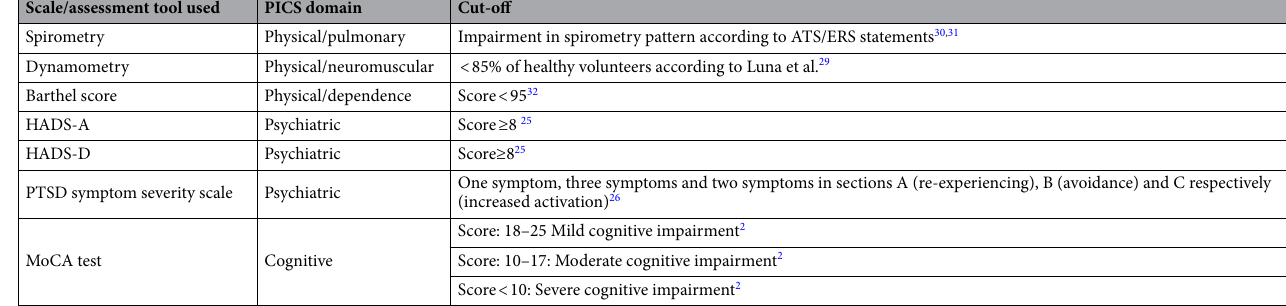
Table 1. Outcomes measured to establish PICS criteria. PICS post-intensive care syndrome, HADS-A Hospital Anxiety and Depression Scale-Anxiety, HADS-D Hospital Anxiety and Depression Scale-Depression, PTSD Post-traumatic stress disorder, MoCA Montreal cognitive